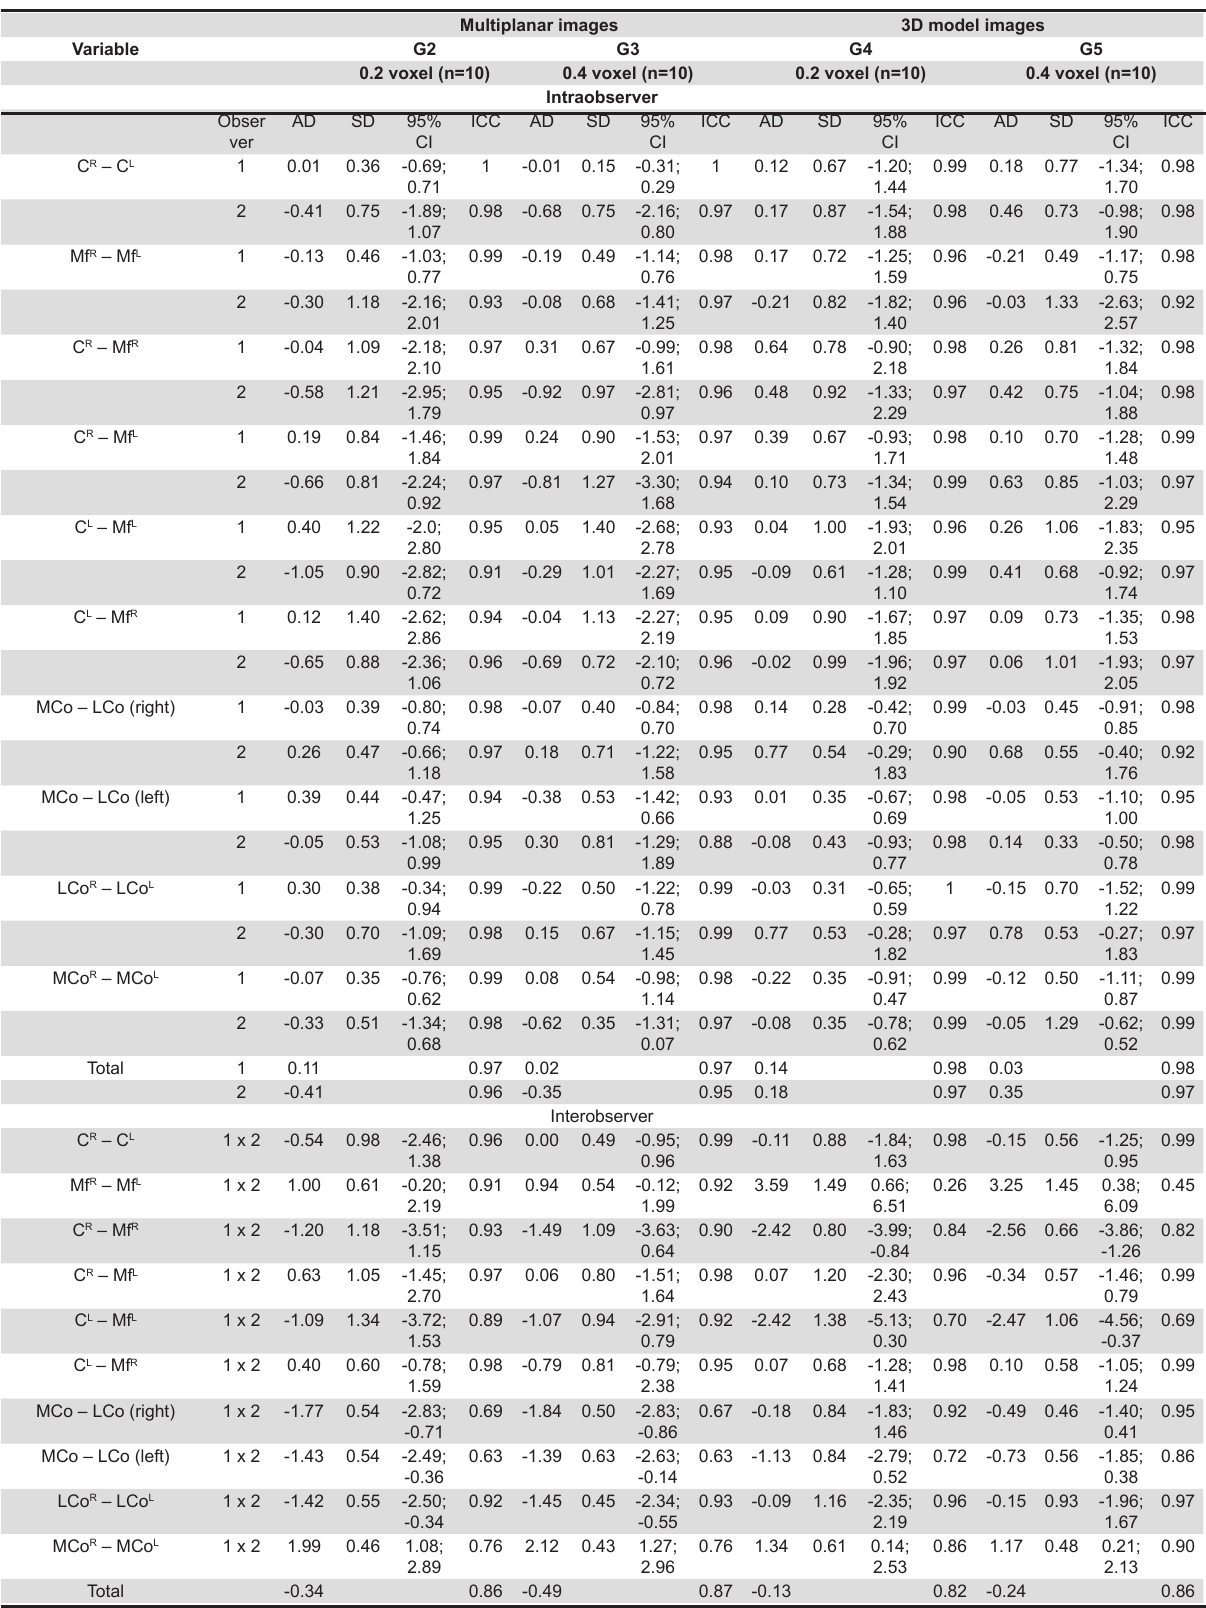
Table 1- Intraobserver and interobserver variation for each group and analysis methods [intraclass correlation coefficient (ICC) and